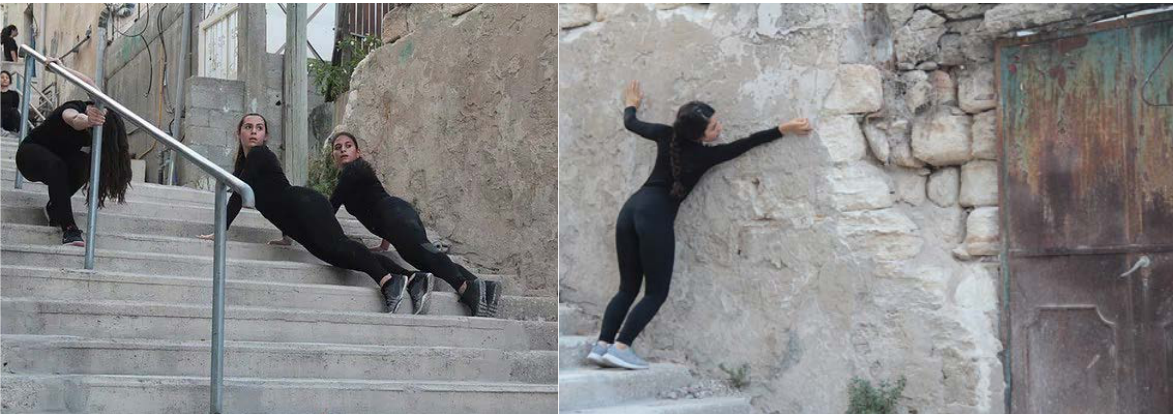
Figure 3. (Left) On the Way: Duet on stairs. Dancers: Adan Azzam, Haya Khouriyeh; (Right) Solo on wall. Dancer: Shahed Jabarin (Photographs: Friend of Aida Dance School).